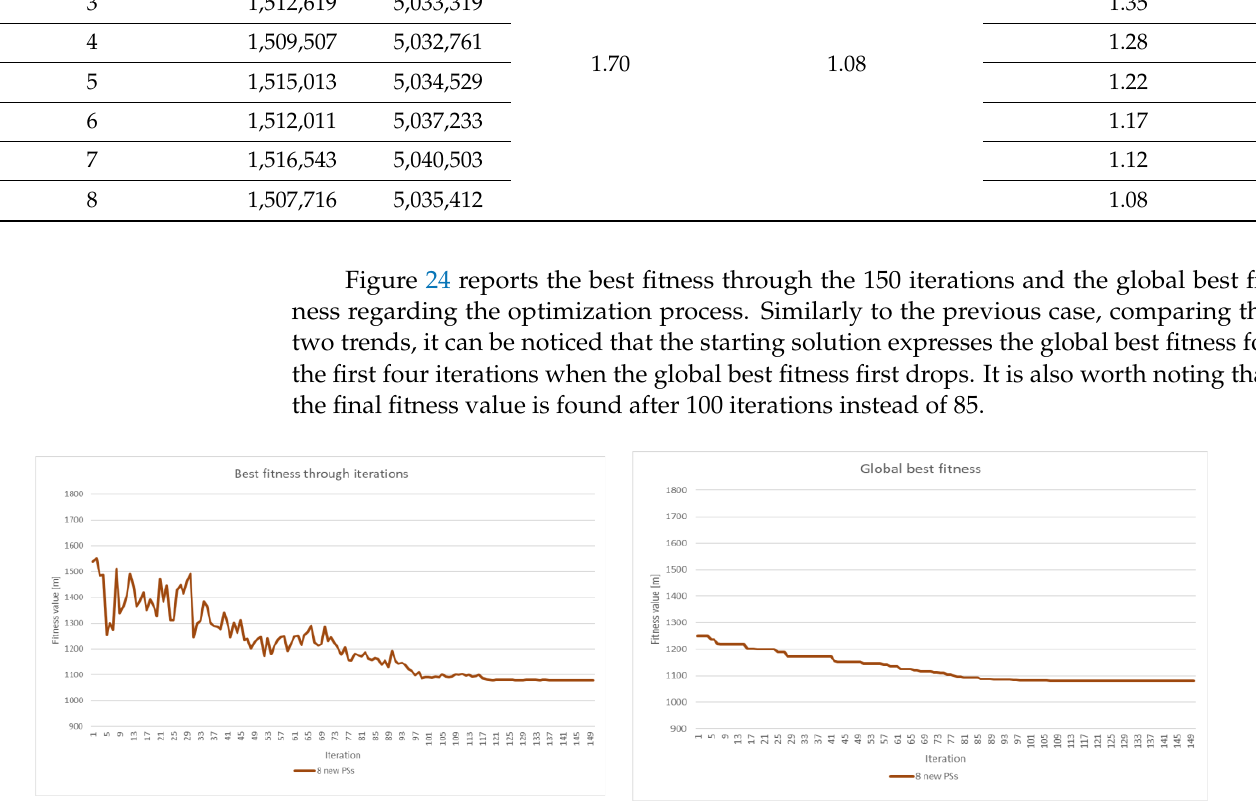
while existing ones are in purple. As depicted in Table 1, the PSO only modifies the location of the two new PSs, i.e., (𝑥 𝑖𝑁𝑒𝑤 𝑃𝑆1 (𝑡); 𝑦 𝑖𝑁𝑒𝑤 𝑃𝑆1 (𝑡)) and (𝑥 𝑖𝑁𝑒𝑤 𝑃𝑆2 (𝑡); 𝑦 𝑖𝑁𝑒𝑤 𝑃𝑆2 (𝑡)) , while the location of the current PSs are taken as they are, e.g., (𝑥 𝐶𝑢𝑟 𝑃𝑆1 (𝑡); 𝑦 𝐶𝑢𝑟 𝑃𝑆1 (𝑡)) . Table 1. Matrix of new and current PSs location. Particles i 𝒙 𝒊𝑵𝒆𝒘 𝑷𝑺𝟏 (𝒕) 𝒚 𝒊𝑵𝒆𝒘 𝑷𝑺𝟏 (𝒕) 𝒙 𝒊𝑵𝒆𝒘 𝑷𝑺𝟐 (𝒕) 𝒚 𝒊𝑵𝒆𝒘 𝑷𝑺𝟐 (𝒕) 𝒙 𝑪𝒖𝒓 𝑷𝑺𝟏 (𝒕) 𝒚 𝑪𝒖𝒓 𝑷𝑺𝟏 (𝒕) … … 𝒙 𝑪𝒖𝒓 𝑷𝑺𝟏𝟑 (𝒕) 𝒚 𝑪𝒖𝒓 𝑷𝑺𝟏𝟑 (𝒕) 1 1,511,310 5,030,533 1,504,760 5,033,038 1,512,544 5,033,515 … … 1,505,567